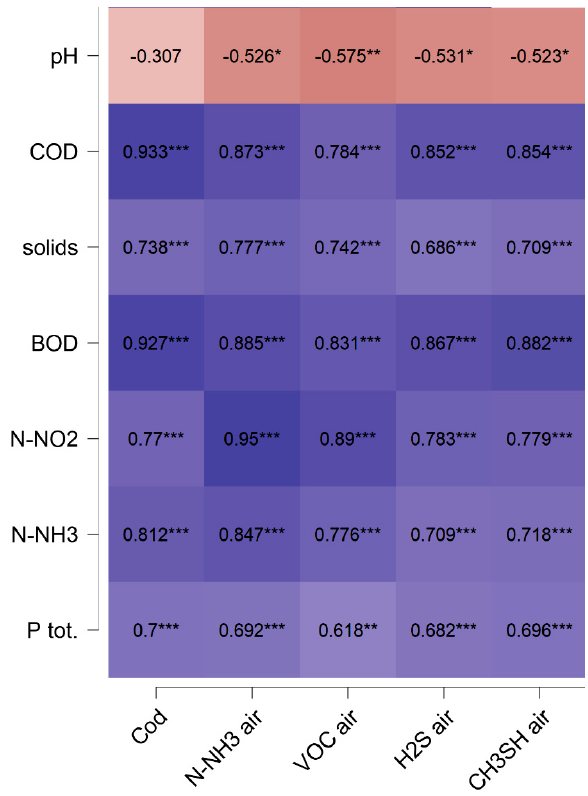
Figure 3. Heatmap of Spearman’s rho correlation coefficient of air and technological wastewater compounds. Note: * p < 0.05, ** p < 0.01, *** p < 0.001. For the pH of process wastewater, the correlation coefficients were